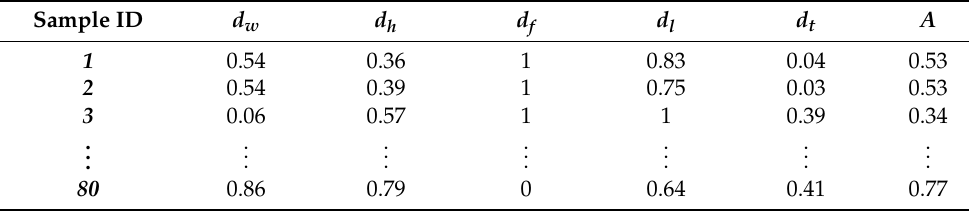
Table 5. Limited normalized